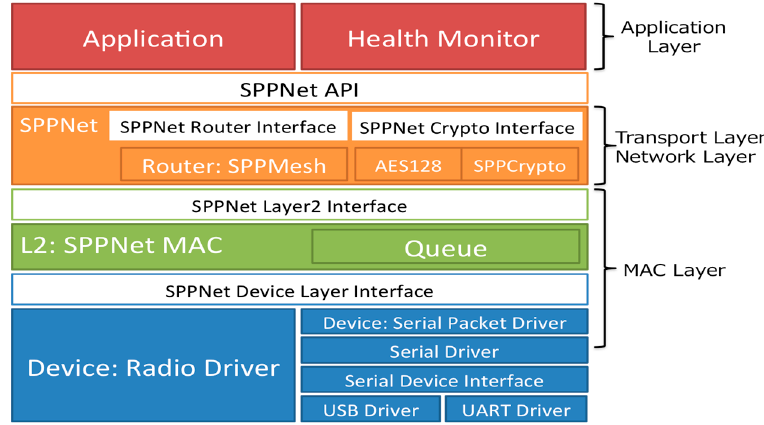
Figure 8. The information about SPPNet protocol used in this study.